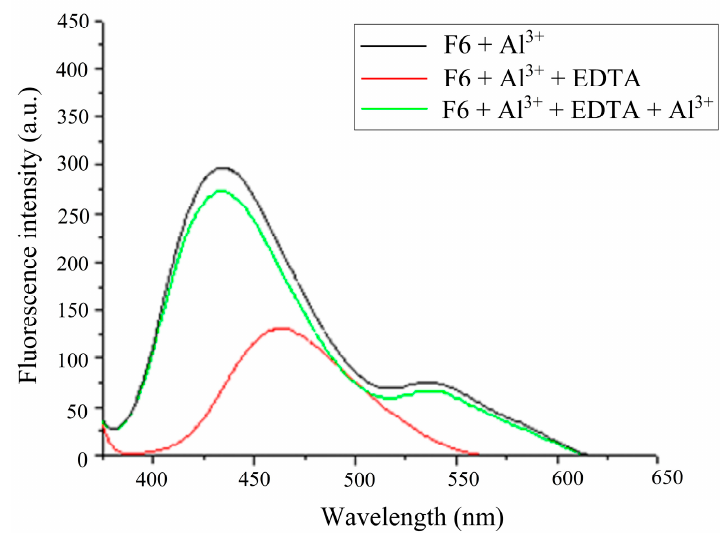
Figure 9. Reversibility study of fluorescent systems.